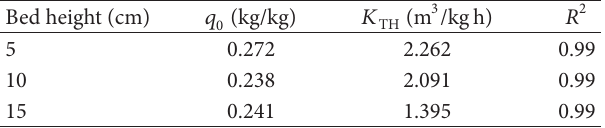
T 3: e omas model parameters.